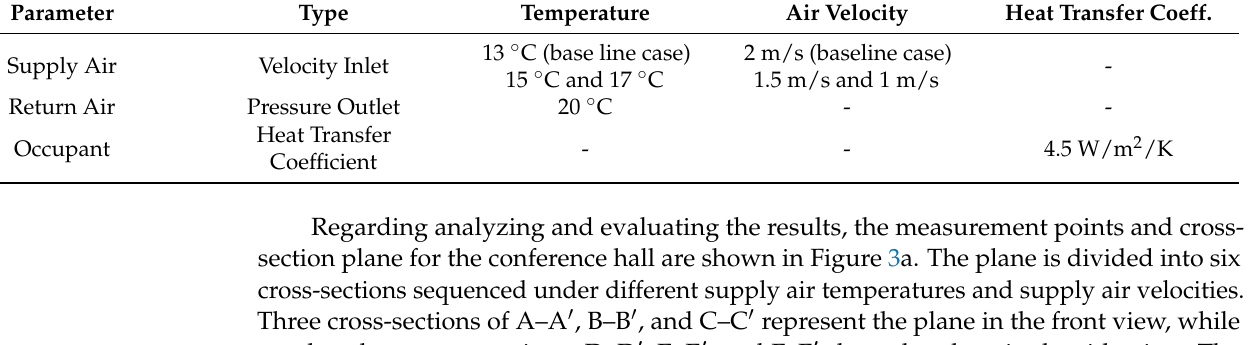
Table 2. The boundary condition for the numerical simulations. Parameter Type Temperature Air Velocity Heat Transfer Coeff. 13 ◦ C (base line Velocity Inlet